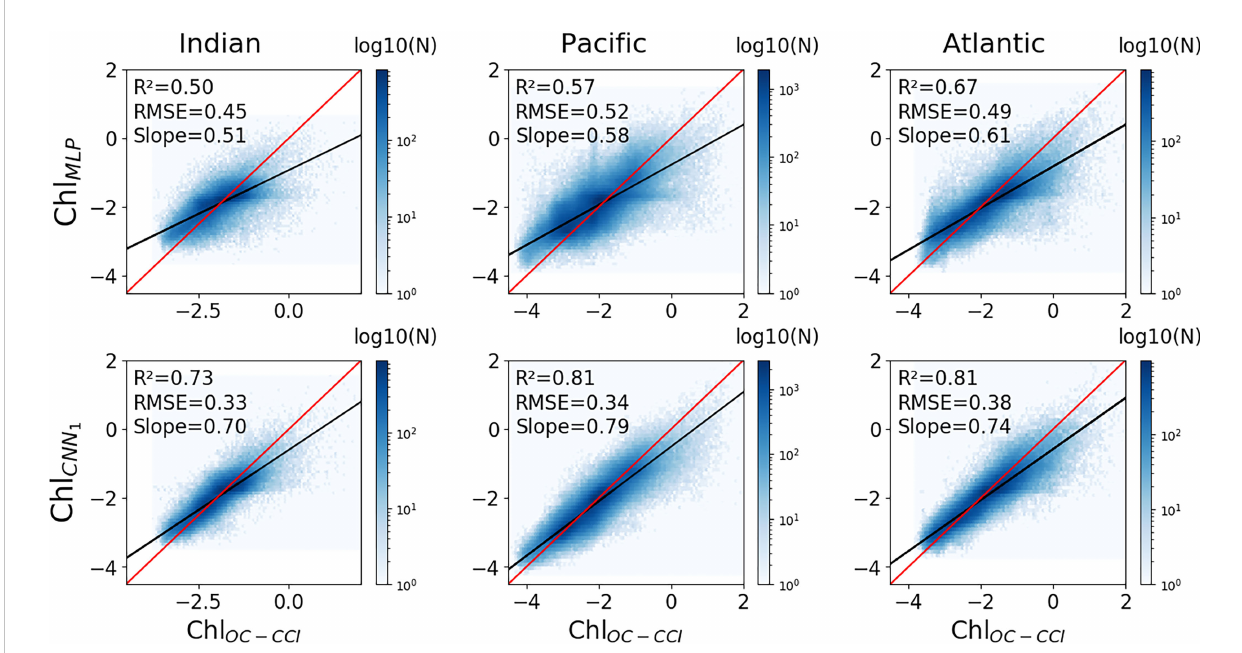
FIGURE 3 Scatterplots of reconstructed log(Chl) from the MLP (upper row) and CNN 1 (lower row) vs. satellite Chl OC-CCI, when explicit geographic predictors (i.e., sin(lat), cos(lon), sin(lon)) are removed from the training phase. Columns correspond to different oceanic basins (left: Indian Ocean, middle: Paci fi c Ocean, right: Atlantic Ocean). The log of Chl OC-CCI vs. reconstructed log of Chl regression lines are plotted in black and the 1:1 regression lines are plotted in red. Plots are color-coded according to the density of observations.